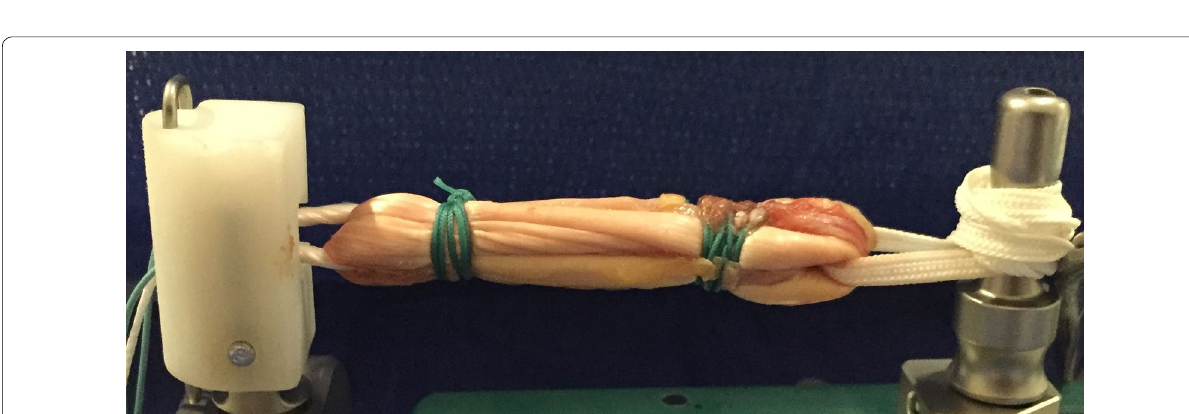
Fig. 2 Prepared quadrupled semitendinosus graft undergoing pretensioning at 500